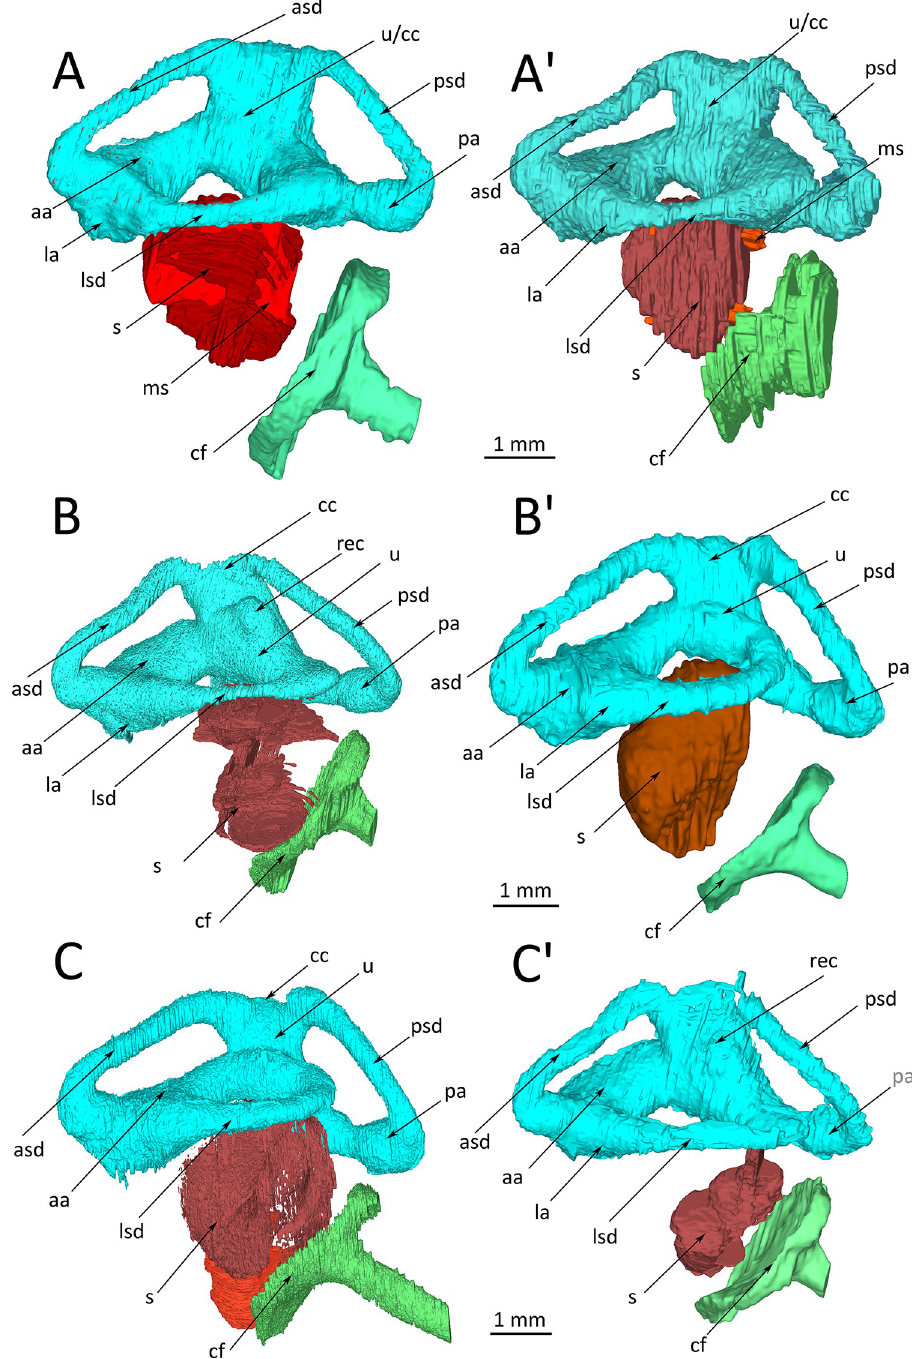
Fig 4. Python regius , orthographic projections of 3D-reconstructions of the membranous inner ear of spider morph pythons. For easy comparisons, images (A), (B) and (C) have been mirrored so that left is rostral and right is occipital. (A) Right, (A’) left inner ear of snake #67532. (B) Right, (B’) left inner ear of snake #67533. (C) Right, (C’) left inner ear of snake #67894. Abbreviations: aa, anterior ampulla; asd, anterior semicircular duct; cc, crus communis; cf, columella footplate; la, lateral ampulla; lsd, lateral semicircular duct; ms, macula sacculi; pa, posterior ampulla; psd, posterior semicircular duct; rec, recess on the utriculus; s, sacculus; u, utriculus.